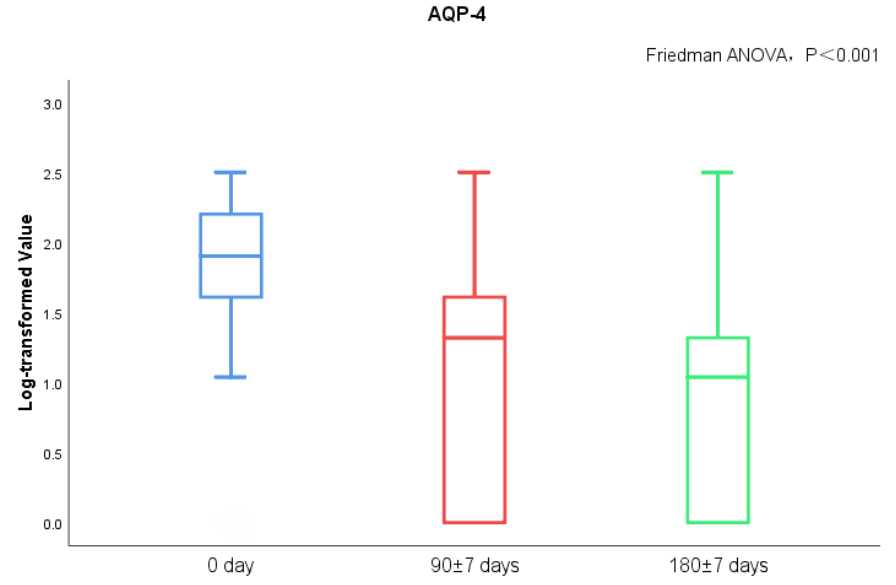
Figure 4. MoCA scores between acute and chronic NMOSD.